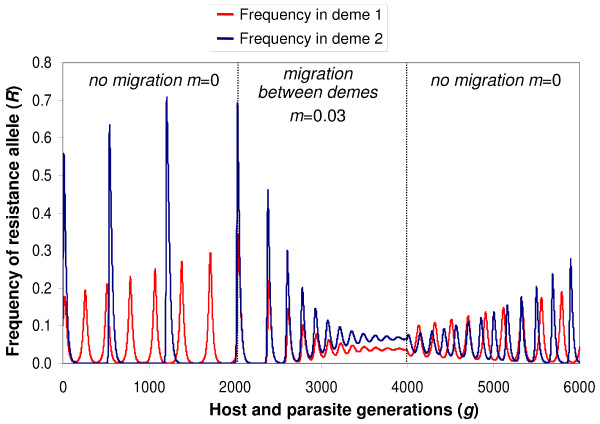
Dynamics of the frequencies of a resistance (RES) allele in two demes linked by migration. The model is of a gene-for-gene interaction between a host RES gene and a parasite avirulence (AVR) gene. The costs to the host of having the RES allele (u) or the parasite the virulence (avr) allele (b) are 0.05 in both demes. The cost to a plant of being diseased (s) is 0.1 in deme 1 (red) and 0.3 in deme 2 (blue). First, the model was run without migration between the demes for 1000 generations; the oscillations in the two demes had different frequencies and spiralled outwards from the interior equilibrium point. After 2000 generations, migration was introduced with a fraction 0.03 of the population being dispersed between the two demes; the oscillations in the two demes became synchronised and damped one another, thus stabilising polymorphism. After a further 2000 generations, migration was eliminated again, resulting once again in expanding, asynchronous oscillations in the two demes.